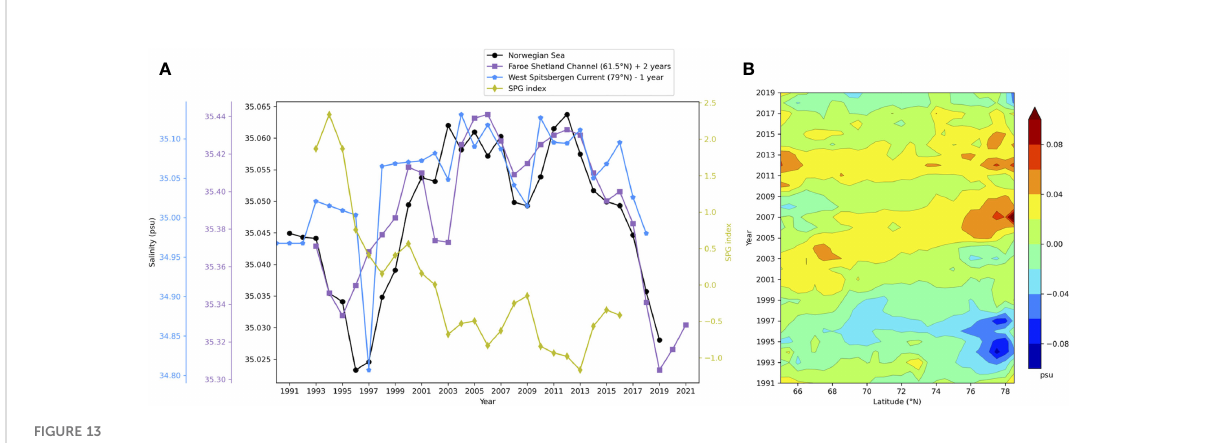
FIGURE 13 (A) Time series of an annual mean of near-surface salinity over the Norwegian Sea, in-situ measurements from Faroe Shetland Channel (61°N) and the core of West Spitsbergen Current at 79°N for the period 1991-2019, and the Subpolar Gyre (SPG) Index from 1993 to 2016 inferred from Berx and Payne (2017). (B) Time-latitude plot of near-surface salinity anomaly along the Atlantic Water